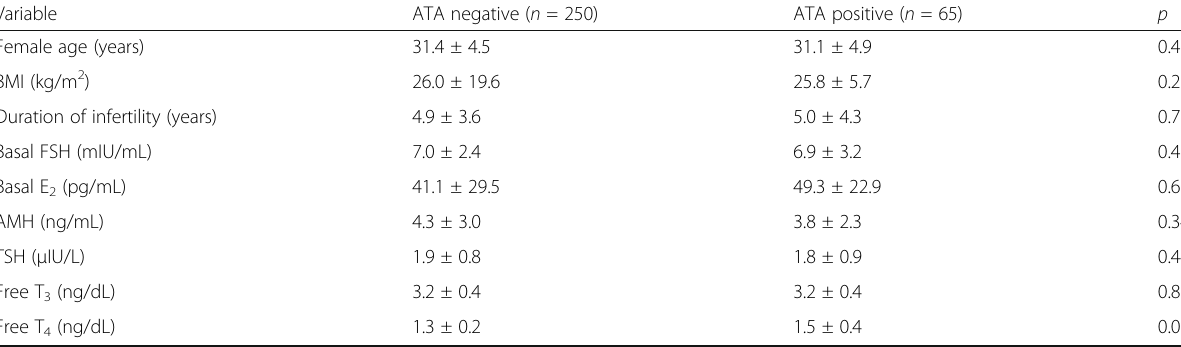
Table 1 Baseline characteristics of ATA-negative and ATA-positive patients Variable ATA negative ( n =